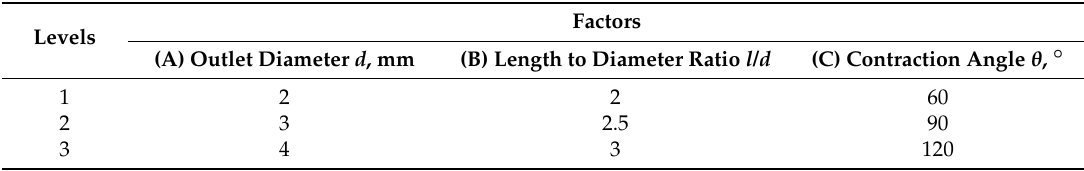
Table 1. Factors and levels of the orthogonal experimental design for the structural parameters of the straight cone nozzle.